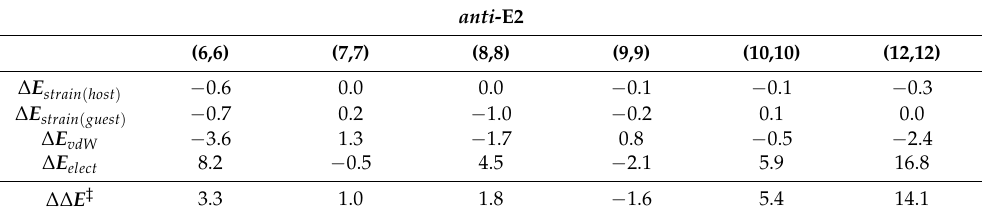
Table 5. Energy contributions (kcal mol − 1 ) to the overall confinement effect on the anti -E2 kinetics.